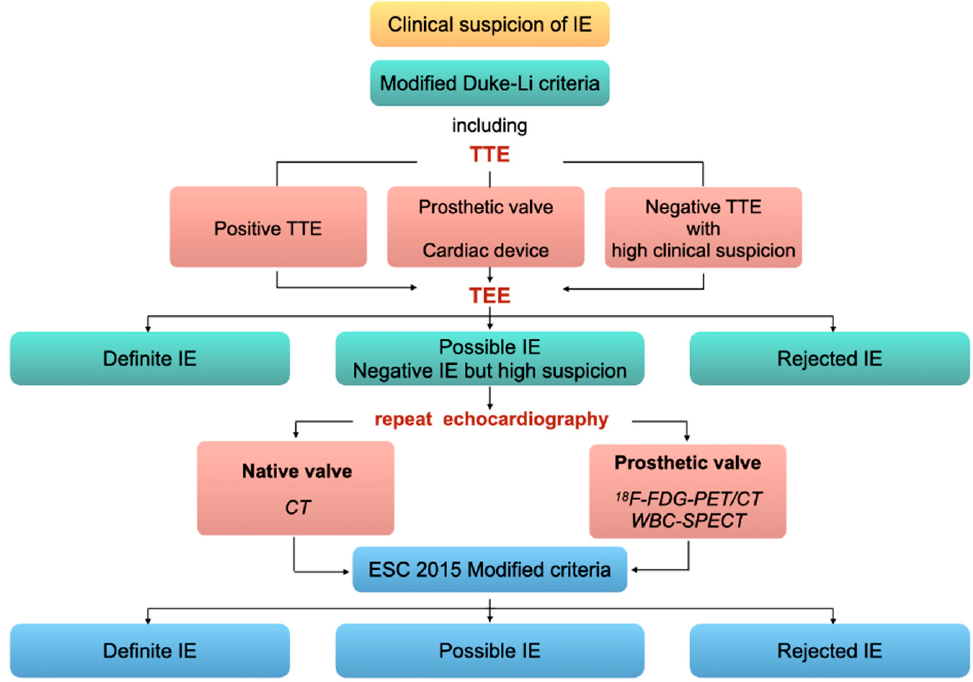
Figure 6. Imaging diagnostic algorithm for valve IE. Adapted from the 2015 ESC guidelines [12] .